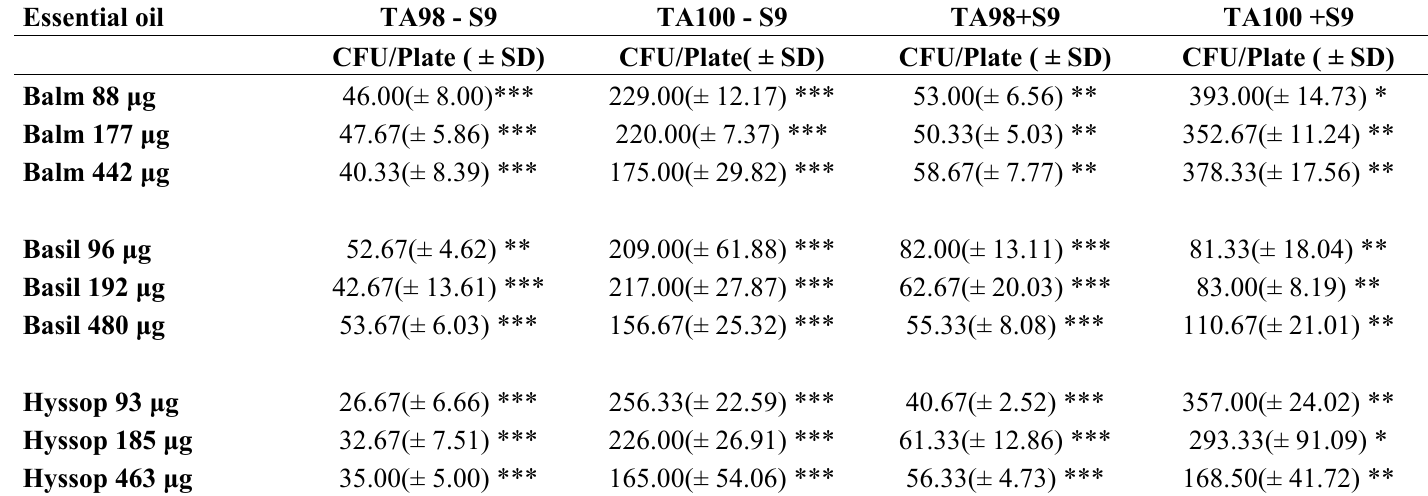
Table 4. Mutagenicity of essential oils: Melissa officinalis L. (balm) , Ocimum basilicum L . (basil), Hyssopus officinalis L. (hyssop) , Lavandula angustifolia Mill. (lavender) , Origanum vulgare L. (oregano), Salvia officinalis L . (sage), Thymus vulgaris L. (thyme). Data are expressed as number of his+ revertant colonies/plate (mean ± standard deviation -SD-) in strains S. typhimurium TA98 and TA100 in presence (+S9) and absence (-S9) of the metabolic